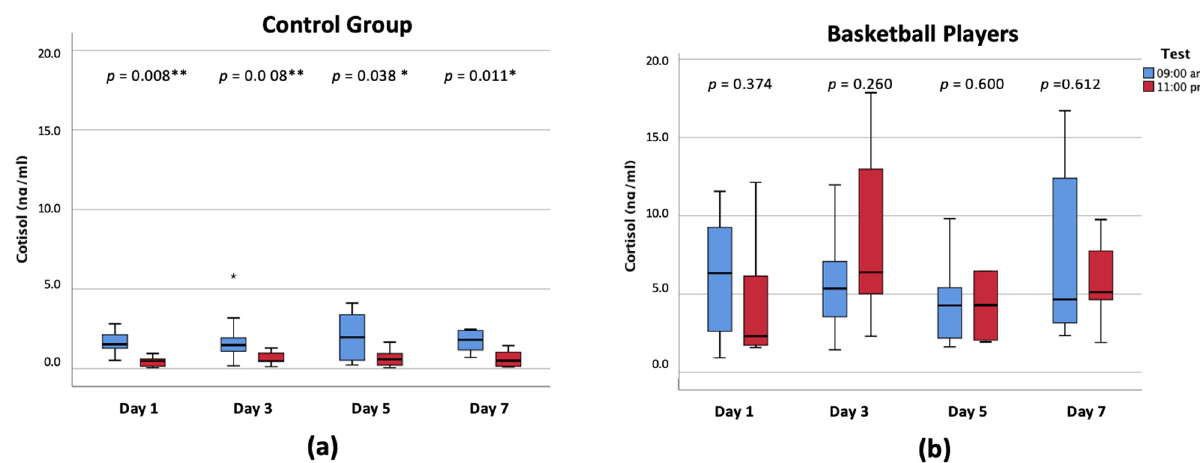
Figure 1. Morning and night-time cortisol levels for both groups ( a ): control group; ( b ): basketball players) * Significant differences p < 0.05.